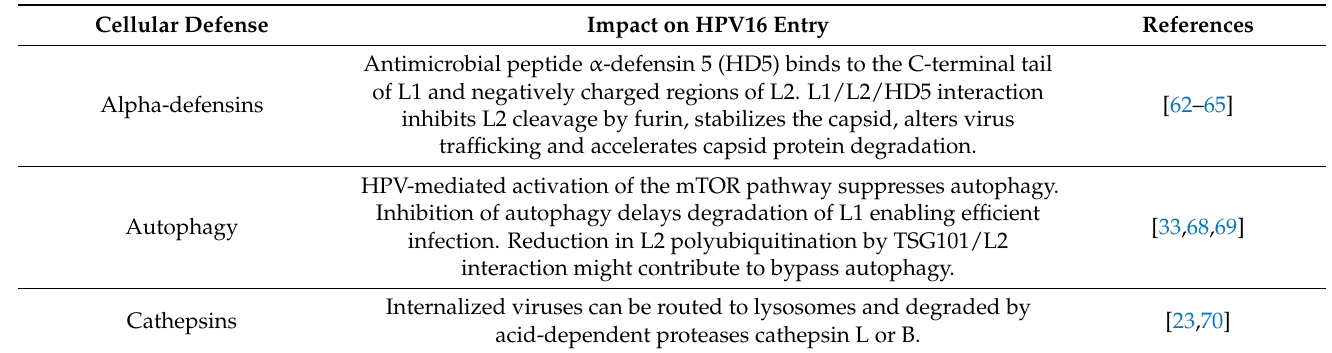
Table 1. Cellular defense mechanisms and antiviral factors providing intrinsic immunity against HPV16 during the entry pathway are listed in alphabetical